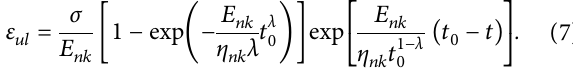
Figure 3: Damage viscoplastic